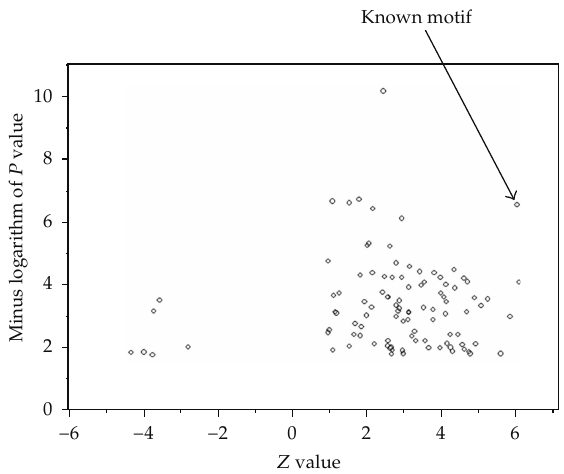
Figure 3: Z -value of the motifs. We choose the 100 sequences found in the upstream of Ace2 -regulated S. cerevisiae genes with the smallest overrepresentation P -values and compute their Z -values in the multiple alignments of orthologous upstream sequences of the four related yeast species. The arrow points to the known motif GCTGGT of Ace2 in S. cerevisiae . The Z -value of the known binding motif is greater than that of the most other